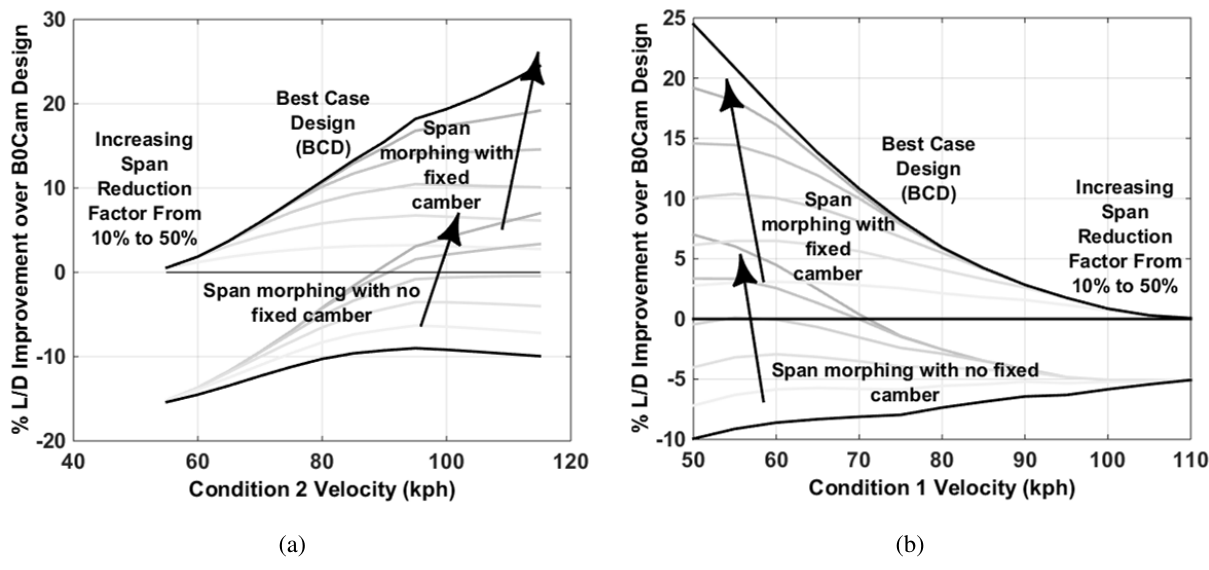
Figure 12. Aerodynamic efficiency for variable maximum allowable span modification over variable speed ranges normalised to the baseline camber design. ( a ) Aerodynamic efficiency for low speed fixed at 50 kph; ( b ) aerodynamic efficiency for high speed fixed at 115